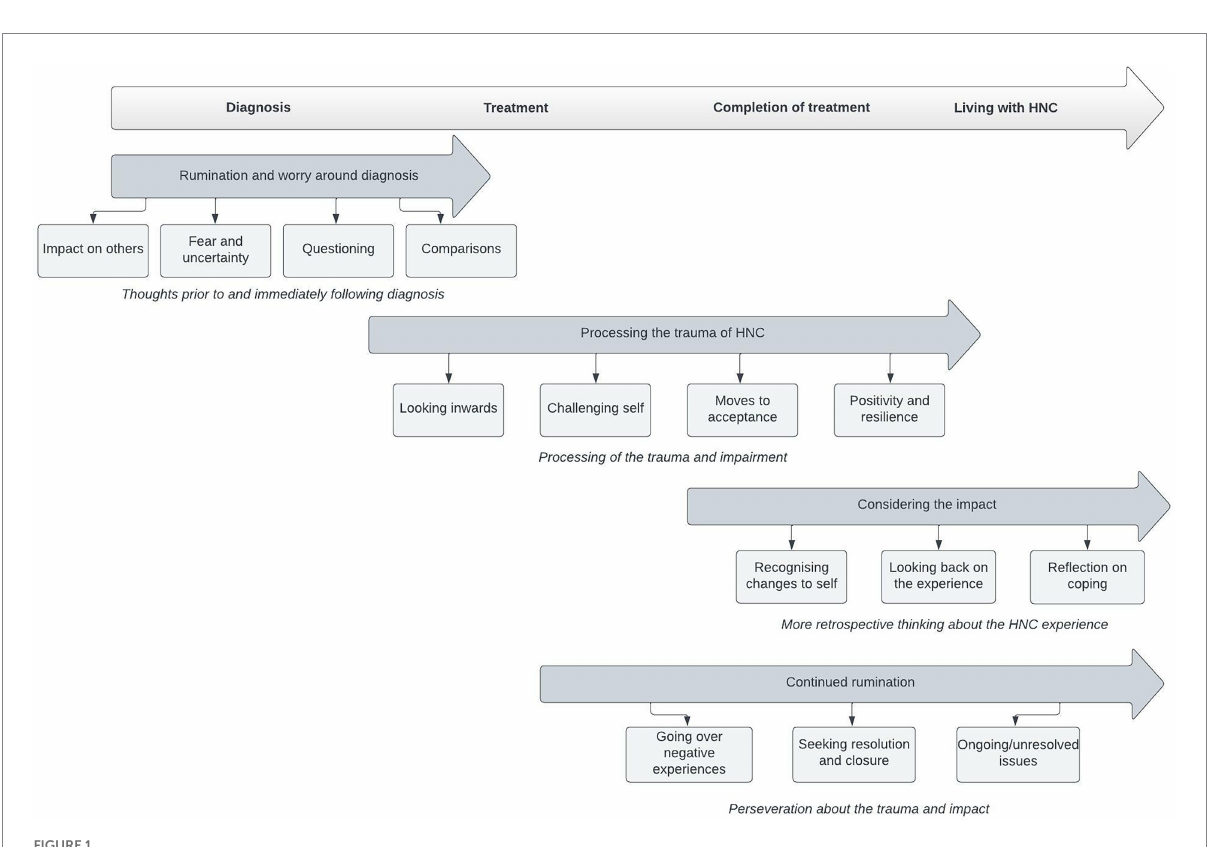
FIGURE 1 Temporal visualization of themes related to rumination in HNC survivors.